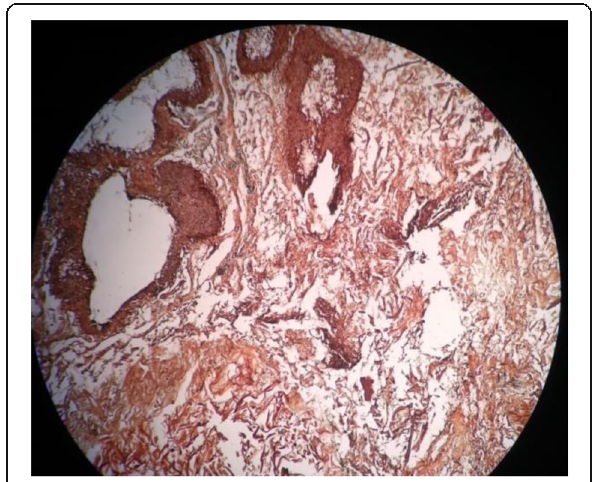
Fig. 6 Gomori methenamine silver staining of the specimen shows broad aseptate fungal